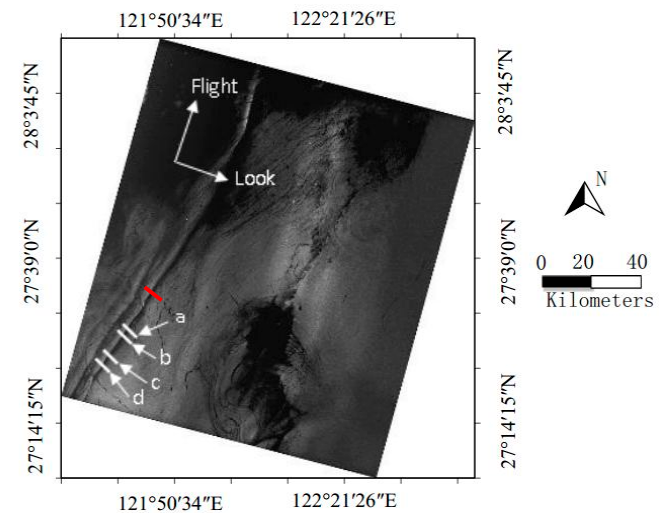
Figure 7. ERS-2 Ocean SAR image of the East China Sea collected on 11 March 2006, at 02:24 UTC. The four white data lines a, b, c, and d are the profiles for comparison between the proposed method, the SAR raw image intensity minus N 0 and the optimal parameter estimation method of internal waves [23].